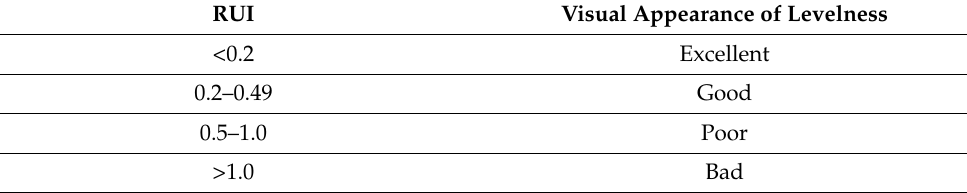
Table 1. Interpretation of the RUI